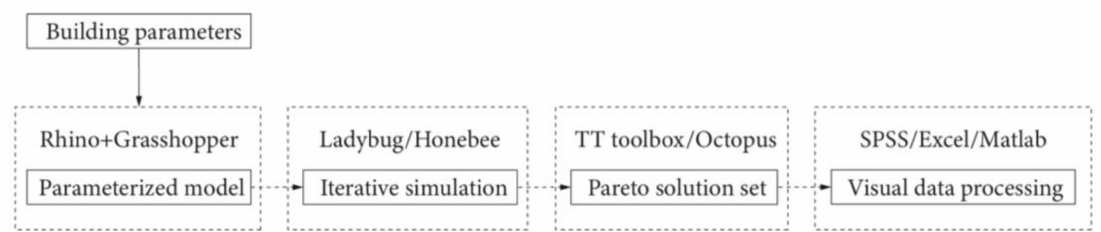
Figure 6. Parametric building optimization